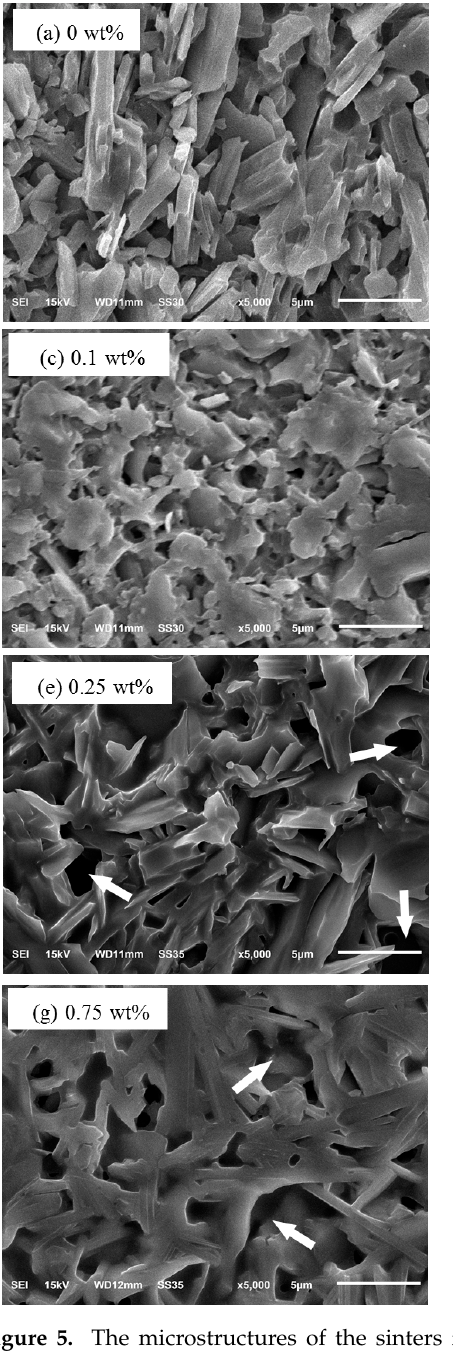
wt%; ( c ) 0.1 wt%; ( d ) 0.15 wt%; ( e ) 0.25 wt%; ( f ) 0.5 wt%; ( g ) 0.75 wt%; ( h ) 1 wt%.